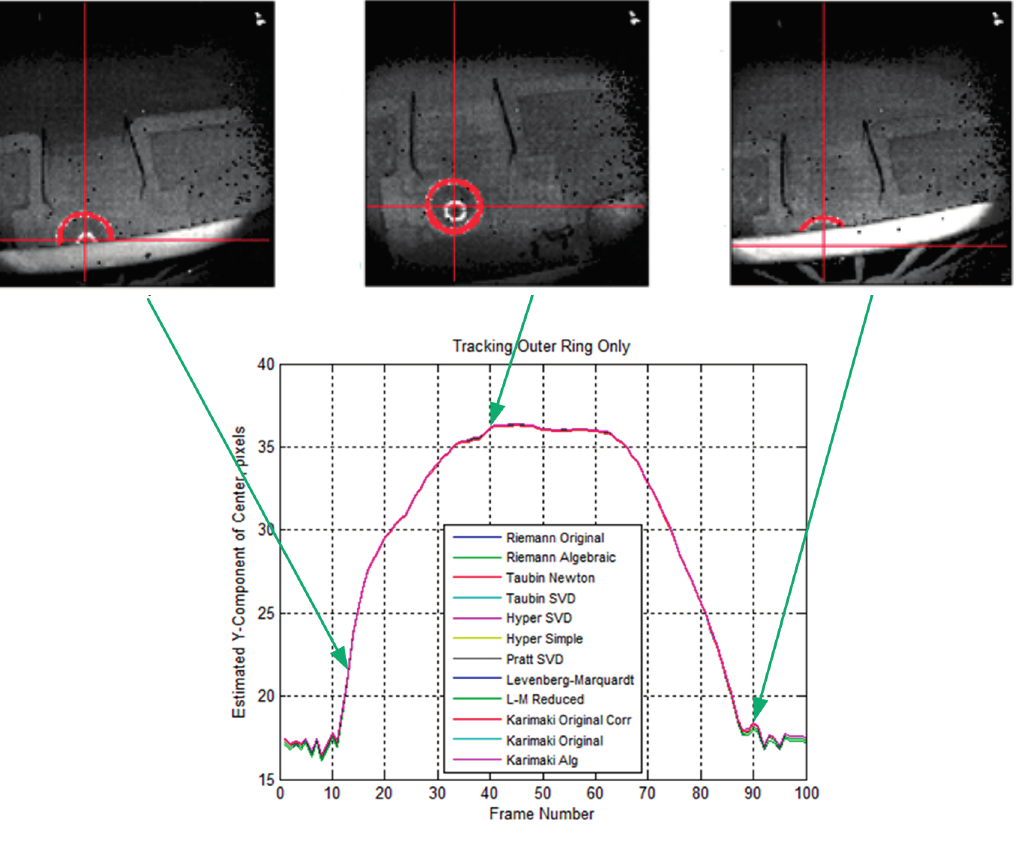
Figure 7. Comparison study of different circle fitting algorithms by using only the outer ring. The upper plots from left to right are the intensity images acquired from the 3D Flash LIDAR for frames 13, 40 and 90. Pixels segmented for the outer ring only are shown in red, and the red cross-hair shows the estimated center using the Taubin SVD algorithm [65]. Since the primary movement is in the y-direction, the lower plot shows the estimated Y component of the ring’s center vs. frame number for each of the 12 fit algorithms indicated in the legend. The plot shows very close agreement of all 12 algorithms with the real drogue data, including those frames where part of the ring is occluded by the railing on the balcony. While the ground truth of the actual center is not available, the estimated center in the intensity image appears subjectively to be reasonably accurate. Barrel distortion of the receiver lens is evident in the railing, but not particularly noticeable in the ring image or the estimate of the ring’s